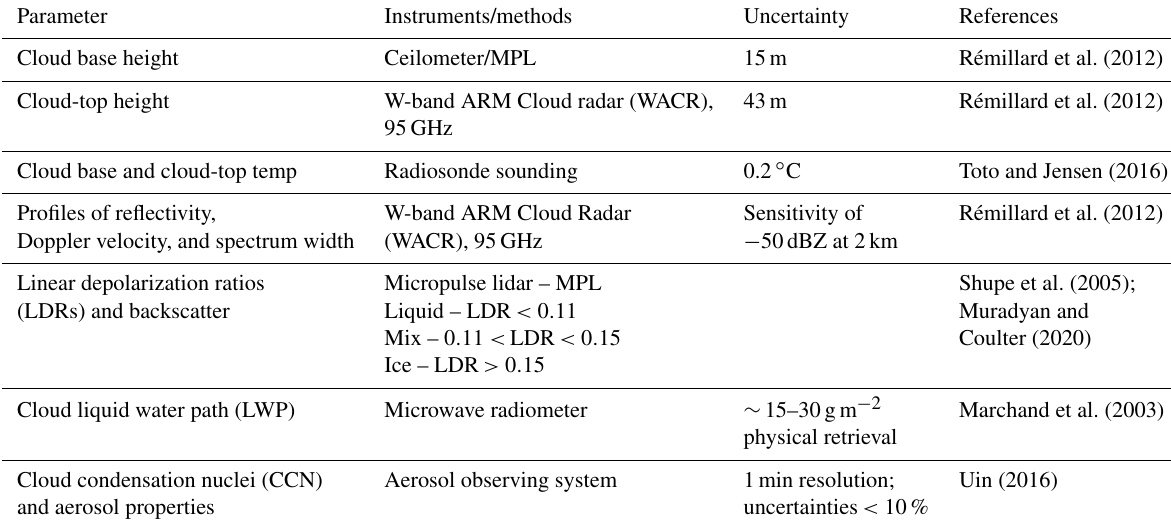
Table 1. ARM AMF2 instruments and their corresponding measurements and uncertainties used in this